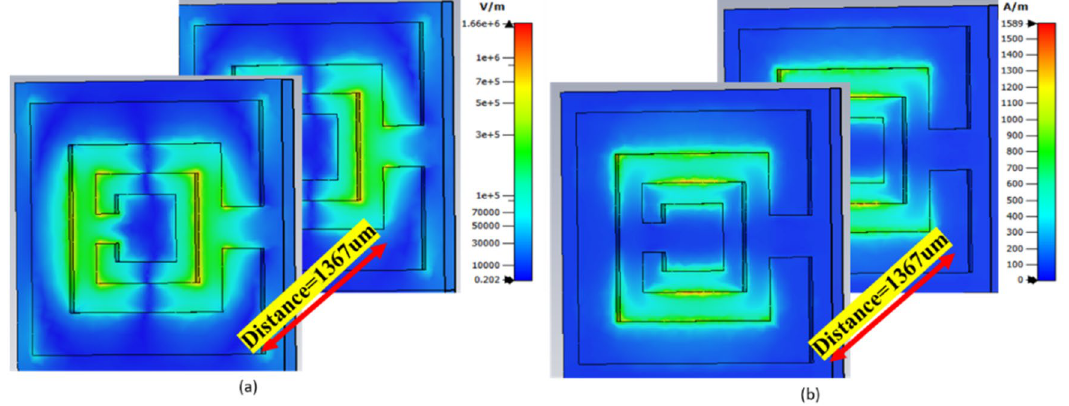
Figure 2. Simulated ( a ) Electric field and ( b ) Magnetic field. Fields’ direction and the coupling are similar to the single unit layer, the difference to the single unit was the amplitude of the fields.